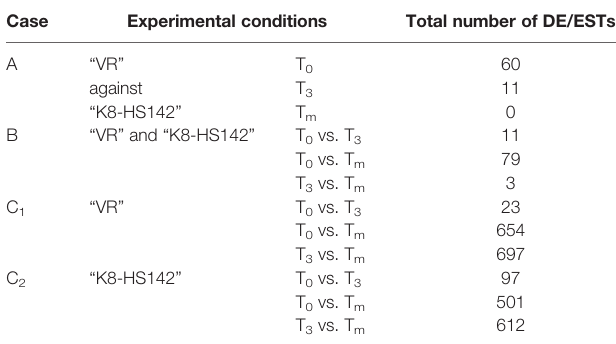
ThetotalnumberoftheDEESTsarereportedfordifferentcasesofcomparisons:between “ VR ” and “ K8-HS142 ” clonesateachtuberstage(A),betweentuberstagesbutsharedby